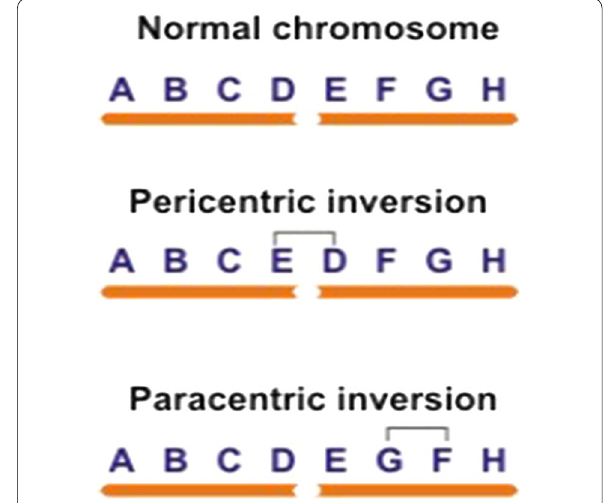
Fig. 8 Chromosomal inversions